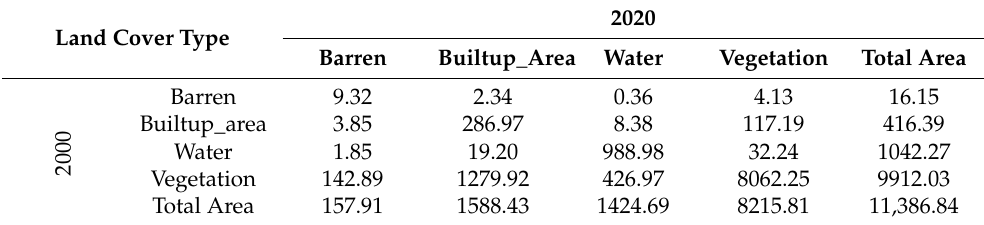
Table 5. The transfer matrix of land cover types in Hefei from 2000 to 2020 (unit: km 2 ). Land Cover Type